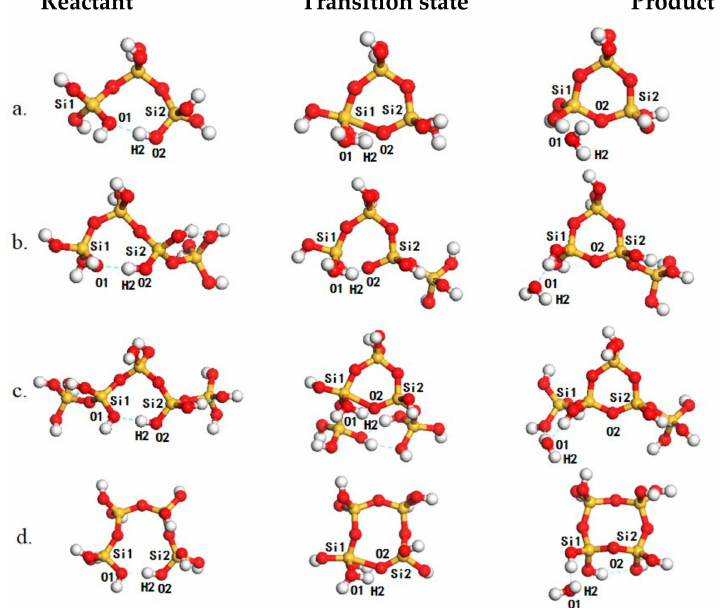
Figure 3. The structures of reaction species, including reactants (left panel), transition states ( middle panel ) and products ( right panel ) for oligomerization for the formation of C 3 ( a ), C 1 ( d ). The Si, O and H atoms are in yellow, red and white,